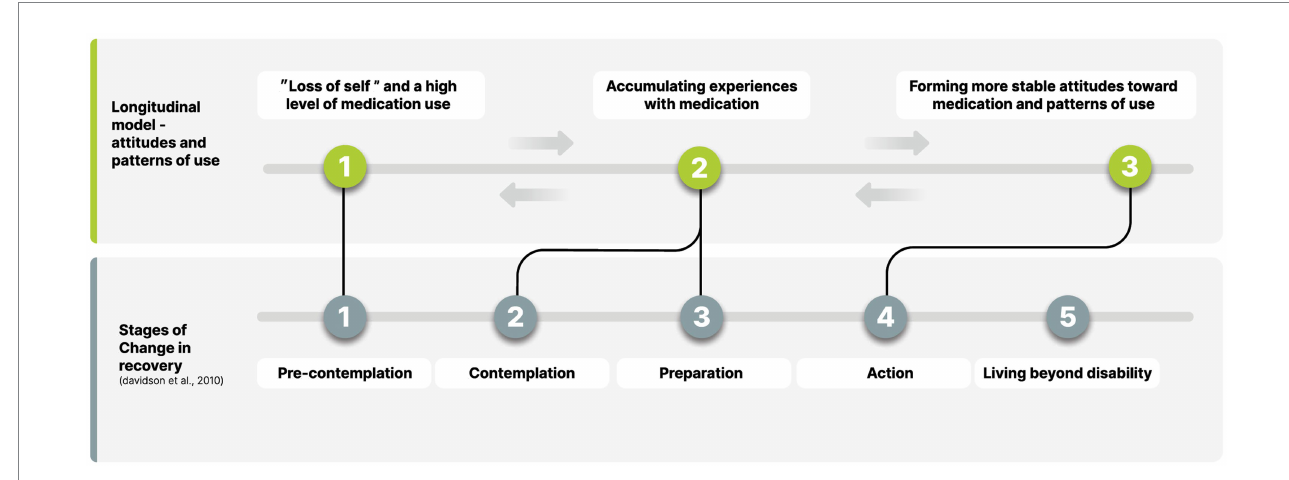
FIGURE 2 Comparison to stages of change in recovery